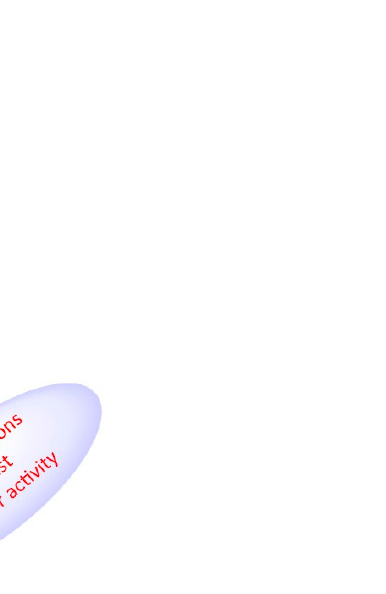
Figure 19. Overview of the most common SAR of steroidal oximes with antitumor and antimicrobial activity.